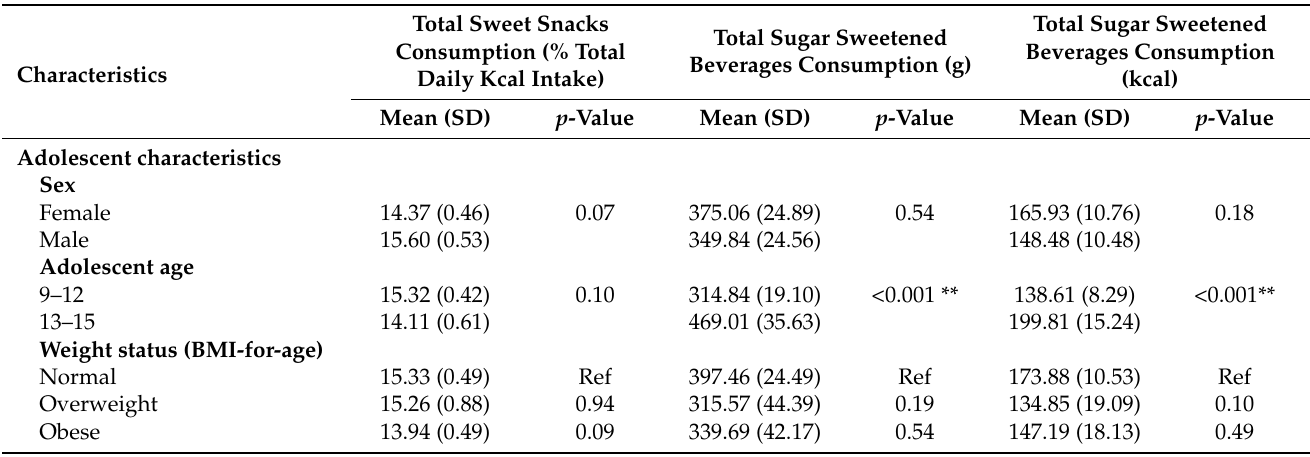
Table 2. The pattern of sweet snacks consumption and sugar sweetened beverages (SSB) based on sociodemographic factors among African American adolescents aged 9–15 ( n = 437) in the B’More Healthy Community for Kids (BHCK) trial at baseline